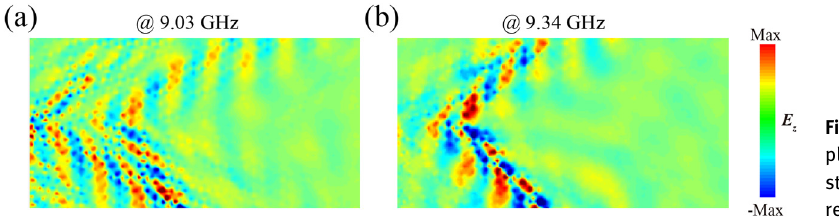
Figure 8: Measured E z distributions in the xy plane at 0.05 mm above the integrated structure at (a) 9.03 GHz and (b) 9.34